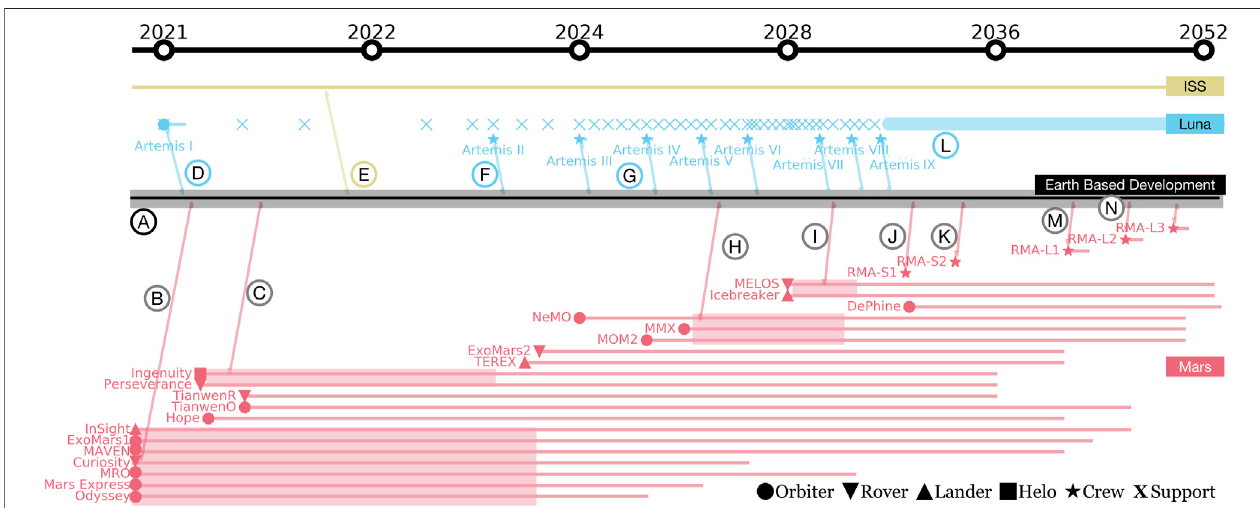
FIGURE 7 | Proposed roadmap from 2021 to 2052 in log 2 -scale time of Earth-based developments (black) and their relationships to ISS (gold), lunar (blue), and Martian (red) missions. Missions range in status from currently operational, to enroute, planned, and proposed. Reference Mission Architecture (RMA)-S is a 30-sol mission, and RMA-L are missions with more than 500 sols of surface operations. RMA-L1 is the mission target for deployment of a biomanufactory. An arrival at target location is denoted with a symbol to indicate its type as orbiter, rover, lander, helicopter, support, or crewed operations. Circled letters are colored by location and correspond to speci fi c milestones or opportunities for biomanufactory